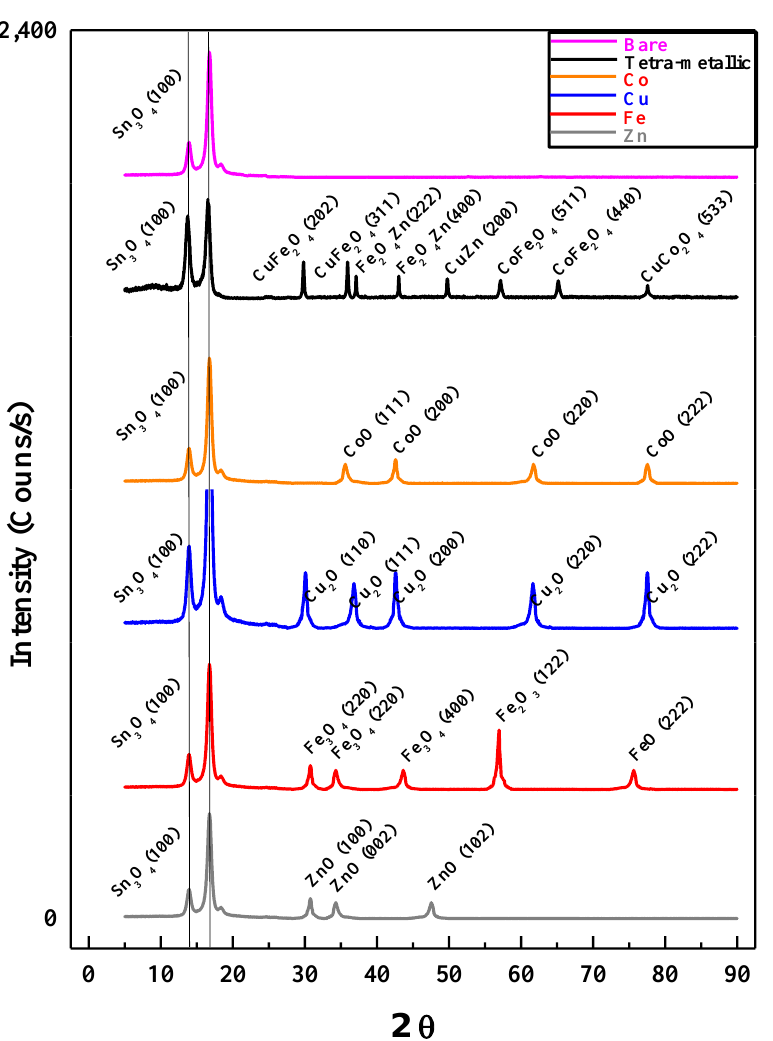
Figure 2. XRD patterns of the FTO with deposited films of oxides of tetra-metallic (Co-Cu-Fe-Zn) Catalyst in 1 M KOH (pH = 13) at deposition potentials of − 1.5 V. For bare FTO (Figure 2), two strong peaks are observed at 13.93° and 16.75°. The peak at 16.75° corresponds to cubic FTO with hkl values of (111) [24] and the peak at 13.93° corresponds to monoclinic fluorine tin oxide with hkl values of ( −1 10) [25]. Meanwhile, for tetra-metallics, the first two peaks in the region of 10° to 20° represent characteristic peaks of FTO. The peaks at 35.91°, 42.59°, 61.73°, and 77.53° correspond to cubic cobalt oxide (CoO) with hkl facets of (111), (200), (220), and (222), respectively [26]. These peak matches with the reference code number JCPDS-00-001-1227. Similarly, the XRD pattern FTO peaks between 10 ◦ to 20 ◦ , there are five additional peaks at 2 θ values of 30.09 ◦ , 36.81 ◦ , 42.59 ◦ , 61.65 ◦ , and 77.53 ◦ corresponding to cubic copper oxide (Cu 2 O) with hkl facets of (110), (111), (200), (220), and (222), respectively [26]. This peak pattern has previously been reported by Esmaeeli et al., with an additional peak at 77.53 ◦ [28]. The peak matches the deposition of iron over FTO. After the region of 10 ◦ to 20 ◦ (FTO region), there are five peaks at 30.69 ◦ , 34.29 ◦ , 43.65 ◦ , 56.95 ◦ , and 75.63 ◦ . The first three peaks correspond to cubic magnetite (Fe 3 O 4 ) with hkl facets of (221), (220) and (400), respectively. Peak